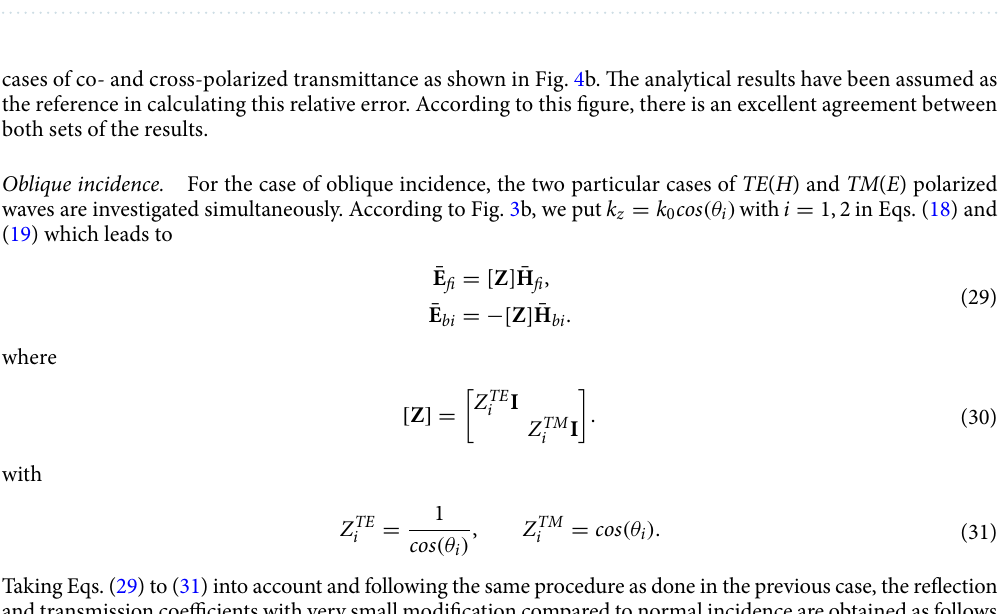
Figure 5. ( a ) Comparison of reflection and transmission coefficients of a free standing infinite graphene sheet obtained using both MoL (solid curves) and analytical formulation (dashed lines) for µ c = 0.5 eV, B 0 = 0.5 T, τ = 0.1 ps and T = 300 K at oblique incidence, ( b ) Relative error between the MoL results and analytical formulations in the calculation of TE and TM transmission